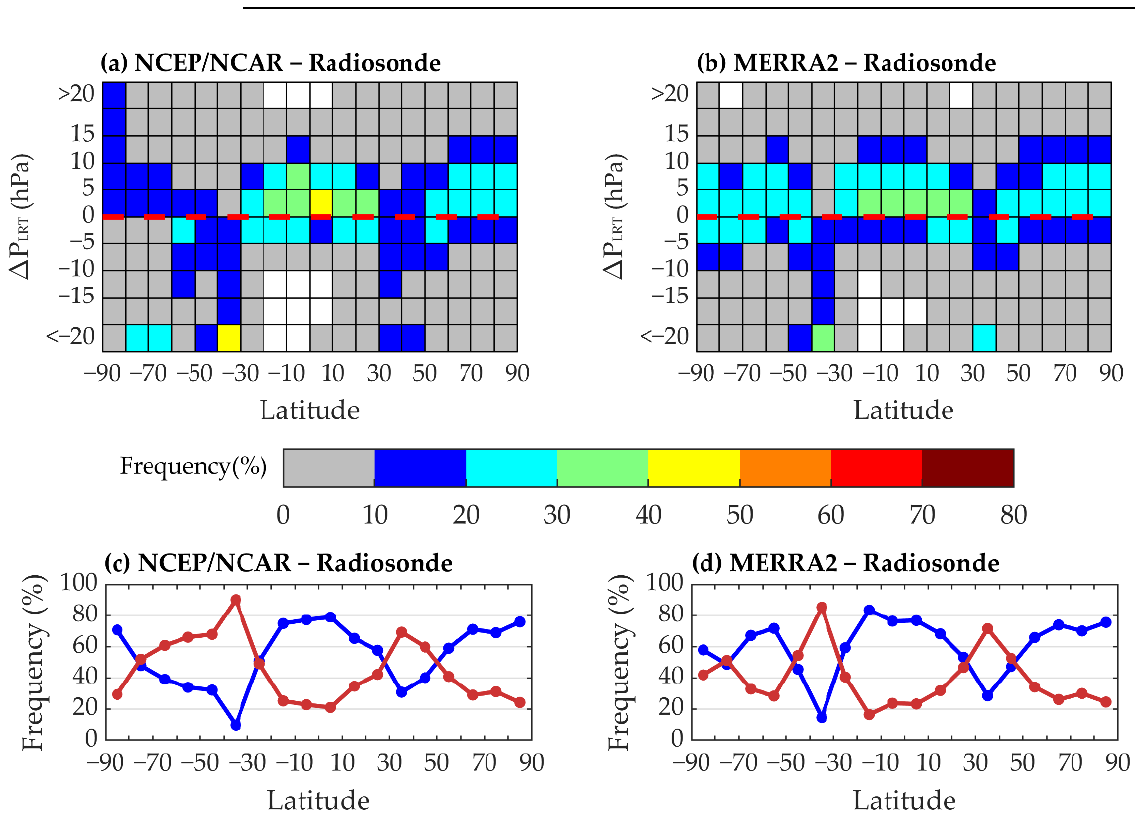
Figure 3. ( a ) Frequency distribution of the P LRT difference ( ∆ P LRT , in hPa) between NCEP/NCAR and radiosonde data in each 10 ◦ latitudinal zone. ( b ) The same as ( a ), but for the P LRT difference between MERRA-2 and radiosonde data. ( c ) The total frequency of positive biases (in blue) and negative biases (in red) in each 10 ◦ latitudinal band for NCEP/NCAR. ( d ) The same as ( c ), but for MERRA-2. The NCEP/NCAR and MERRA-2 data are used in their original resolutions of 2.5 ◦ × 2.5 ◦ and 0.625 ◦ × 0.5 ◦ in longitude and latitude.